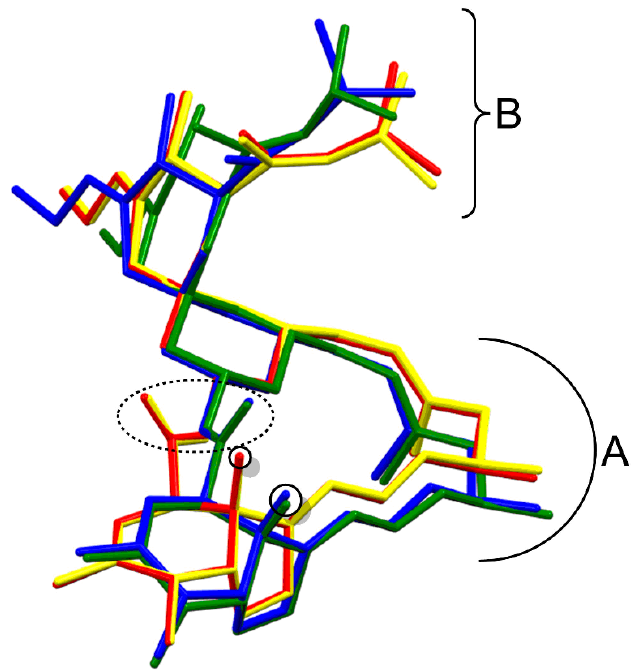
Figure 7. Comparison of the conformations of the moxidectin molecule in the crystal forms described in this paper. The graphical representation shows the different conformations of moxidectin solvatomorphs. Color code: yellow (Moxi·2EtOH), red (Moxi·2 i PrOH), green (Moxi·1.5MeNO 2 ) and blue (form I, CSD reference code GETBOW [12]). The orientation of the 16-membered ring (A) and the spirocycle (B ) are indicated.